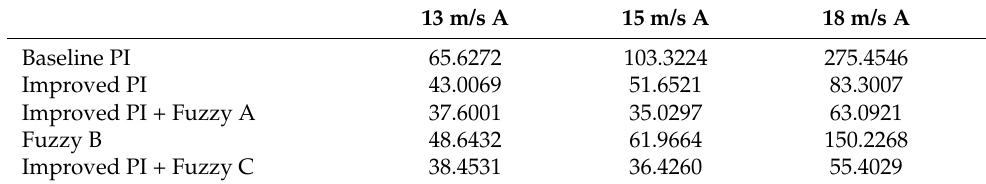
Table 13. Speed Index, SpI